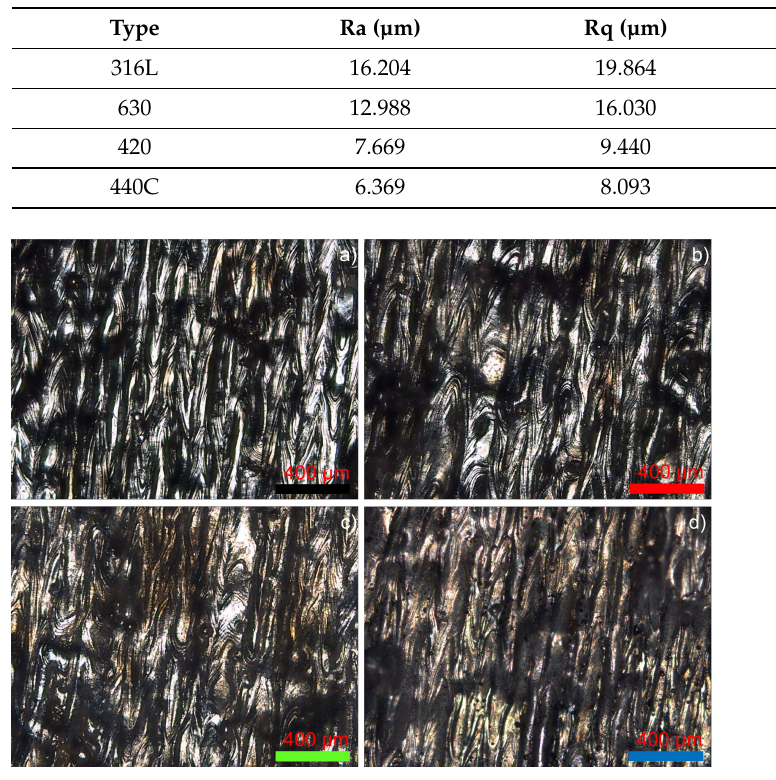
Table 4. Roughness measurements of the tensile test specimens, for each stainless steel.